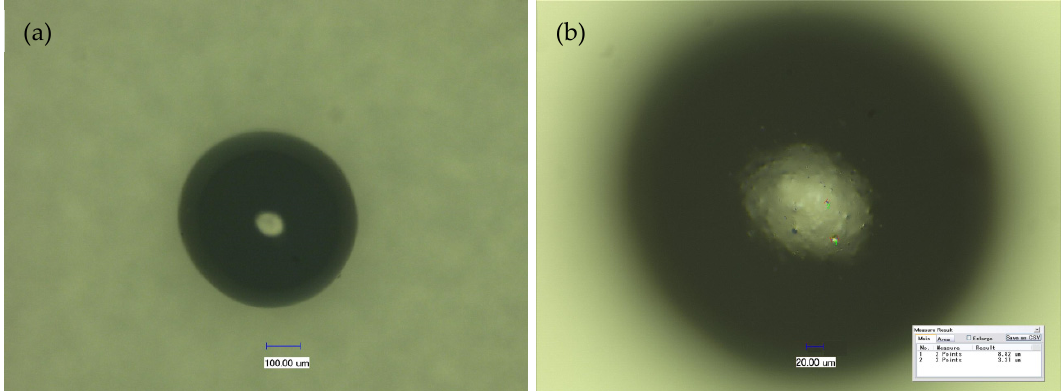
Figure 1. MRCM picture ( a ) and MRCM surface photograph ( b ).